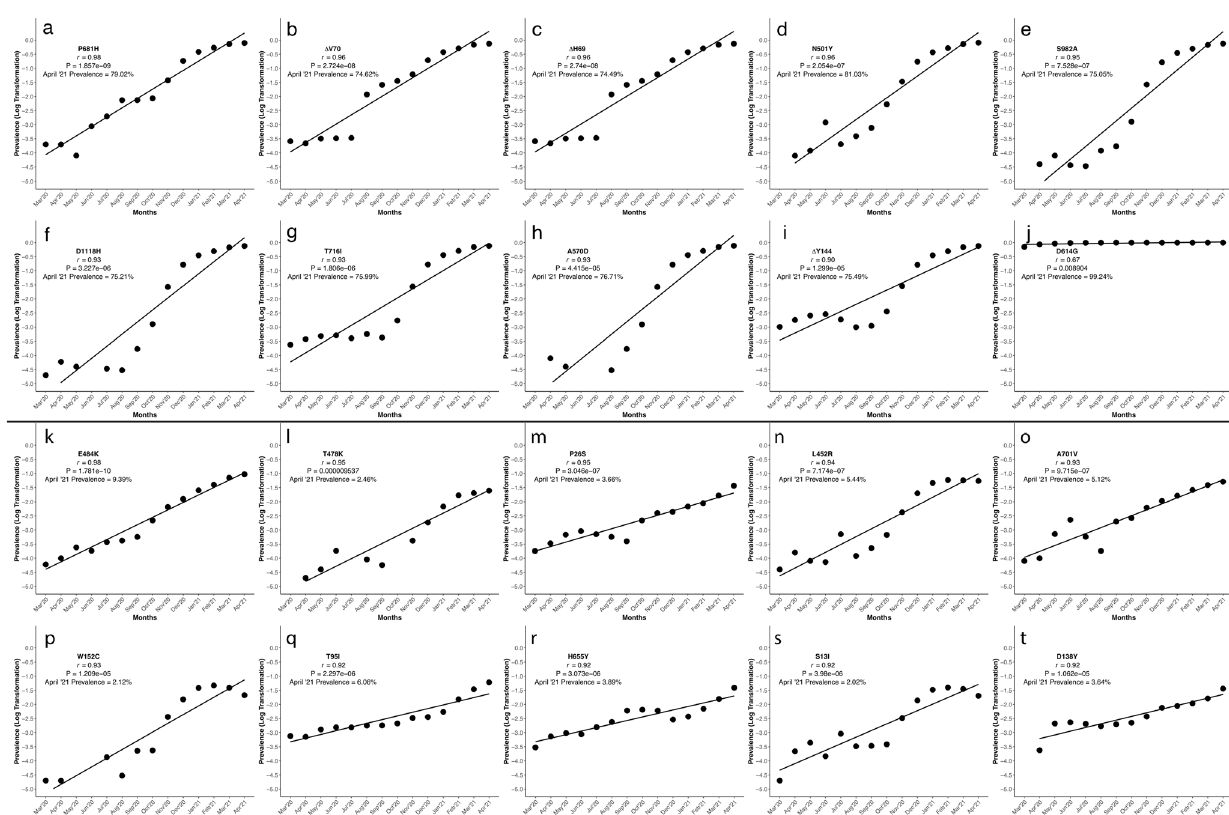
Fig. 5 Pearson ’ s correlation of logarithmically-transformed prevalence ratios of the most emergent SARS-CoV-2 mutations of concern and interest selected via the algorithm. This fi gure shows the graphical representation of the logarithmically-transformed prevalence data used to calculate the Pearson ’ s correlation ( n = 1,483,155 biologically independent samples) of each of the twenty most emerged (of concern) and emergent (of interest) spike protein substitutions and deletions. The substitutions and deletions of concern here are in order of decreasing r value, and each has a unique alphabet identi fi er ( a ) P681H, ( b ) Δ V70, ( c ) Δ H69, ( d ) N501Y, ( e ) S982A, ( f ) D1118H, ( g ) T716, ( h ) A570D, ( i ) Δ Y144, and ( j ) D614G. The algorithm uses the monthly prevalence data from these ten spike protein substitutions and deletions, and they are the most concerning of all spike changes. The substitutions and deletions of interest here are in order of decreasing r value and each unique substitution or deletion is denoted by a letter of the English alphabet, ( k ) E484K, ( l ) T478K, ( m ) P26S, ( n ) L452R, ( o ) A701V, ( p ) W152C, ( q ) T95I, ( r ) H655Y, ( s ) S13I, and ( t ) D138Y. Graphs were generated using open-source R and the ggplot2 package under MIT + license (https://cran.r-project.org/web/packages/ggplot2/index.html). Graphs were compiled and the fi nal fi gure created using